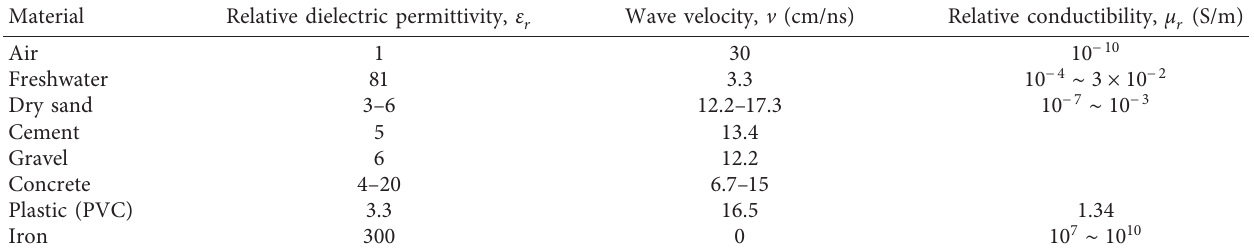
Table 1: Electromagnetic parameters of construction materials